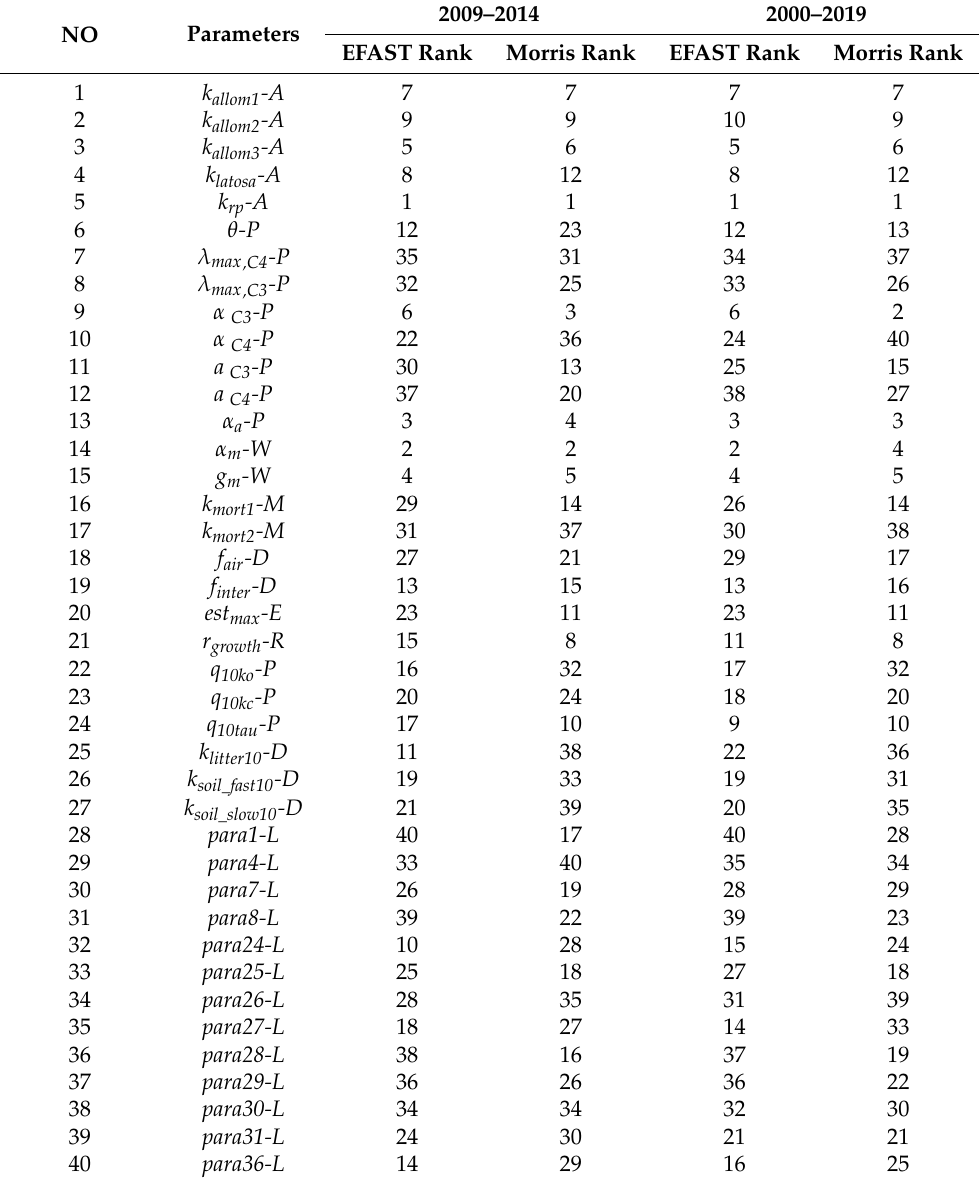
Table 2. Sensitivity analysis rankings of the LPJ model parameters for the NPP output response based on the EFAST and Morris